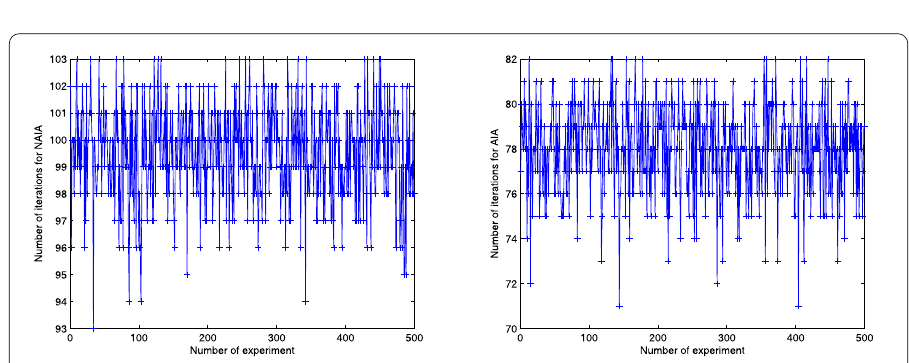
Figure 4 The iterative number of NAIA and AIA for the initial point of Case 4